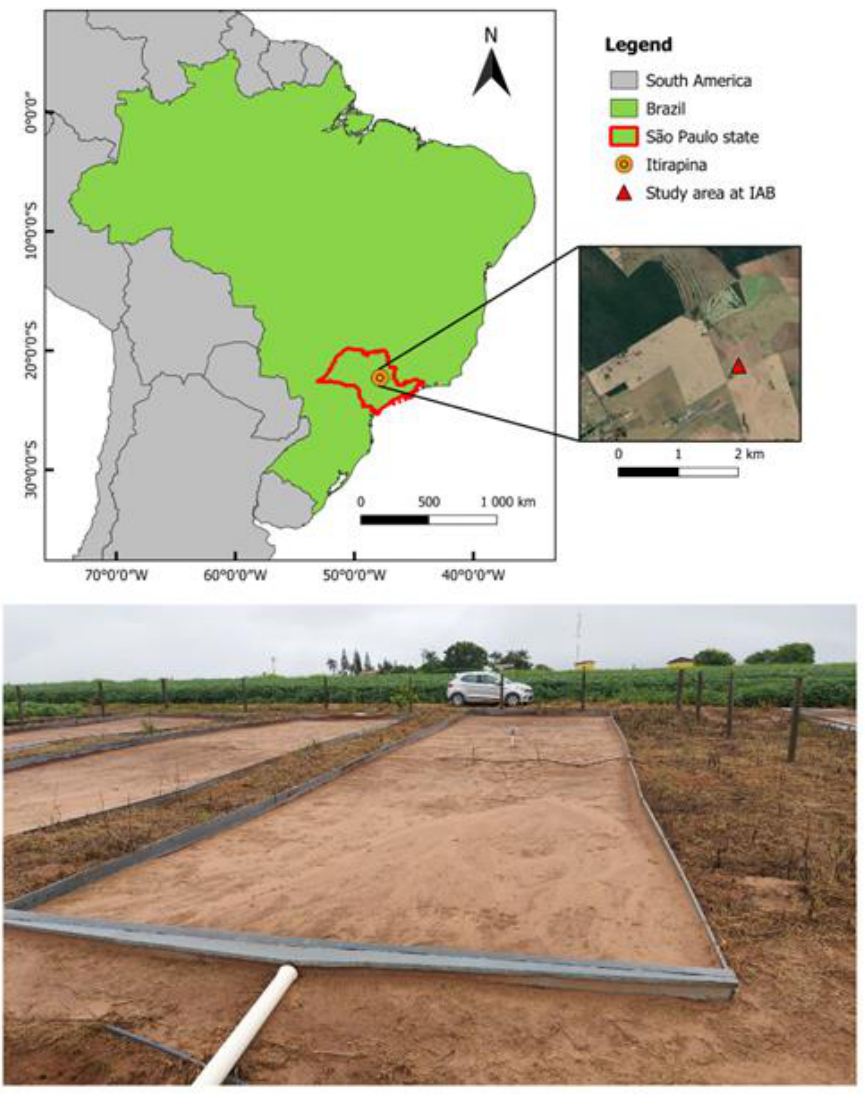
Figure 4. Location of the experimental field site.